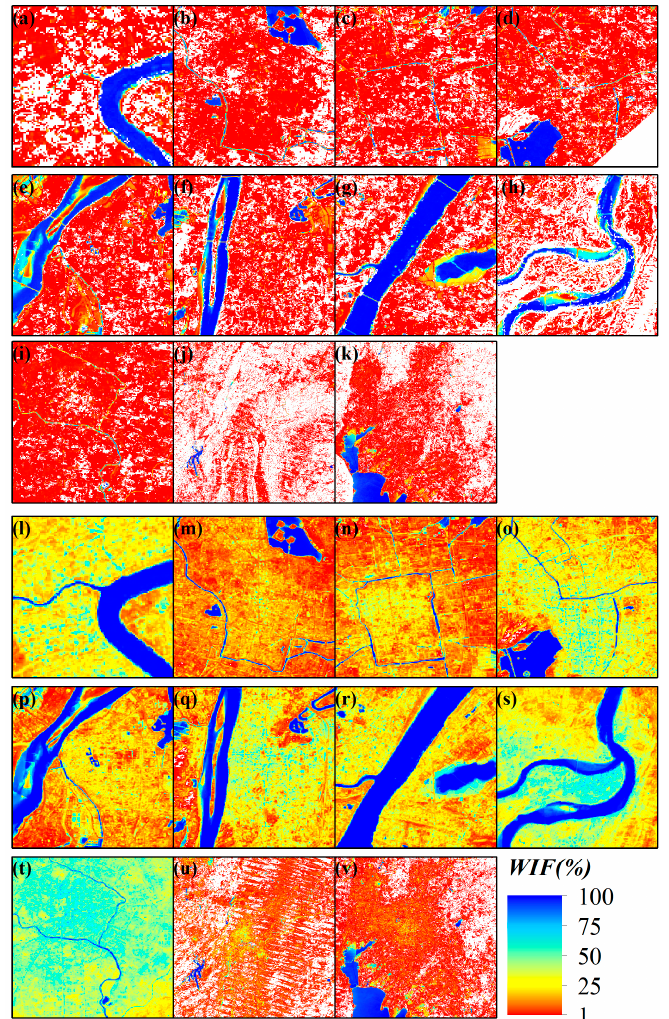
Figure 16. Comparisons of the water identification rule of this study and Zou et al. [28] in urban regions. ( a – k ) indicates the extracted water bodies according to the method of this study in Shanghai, Kunming, respectively. ( i – v ) indicates the resulsts according to the method of Zou et al. [28] in the same cities with ( a – k ).